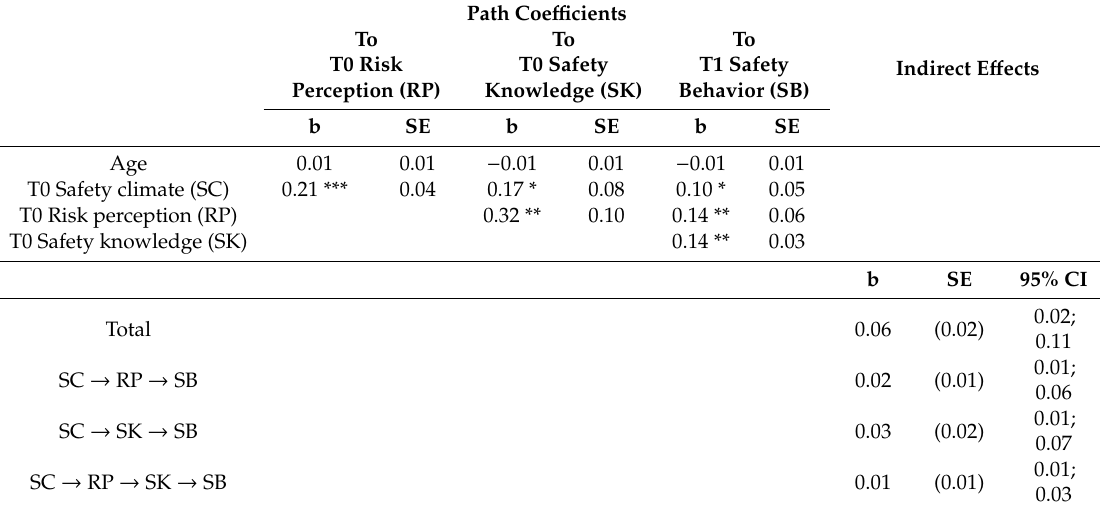
Table 2. Path coe ffi cients and indirect e ff ects for mediation models. Path Coe ffi